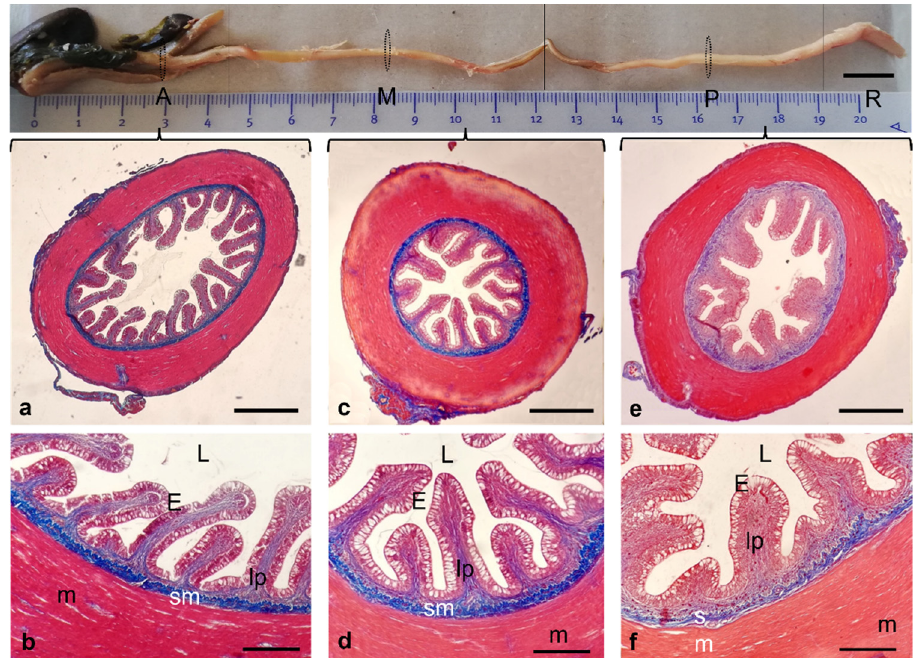
Figure 11. Gross anatomy: photographical insert of the gastrointestinal tract of H. niloticus ; intestinal segments: anterior (A), intermediate (M), posterior (P), and rectum (R). ( a – f ) Masson Trichrome with Aniline Blue staining. ( a , b ) Micrographs of transversal sections of anterior, ( c , d ) intermediate and ( e , f ) posterior intestine. ( b , d , f ) Micrograph of the intestinal mucosa: epithelium (E), lumen (L), lamina propria (lp), submucosa (sm), muscularis (m). Scale bar: 1 cm (insert), 100 μ m ( a – c ), 50 μ m ( d – f ).